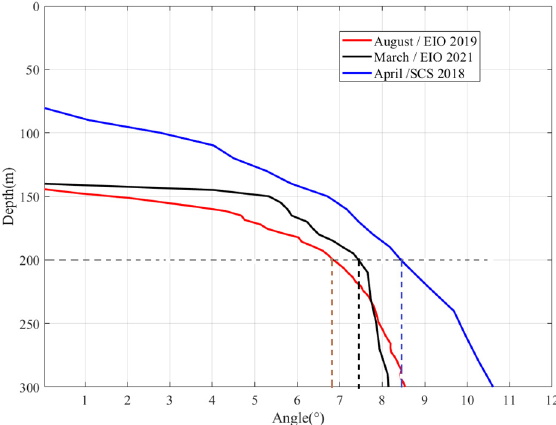
Figure 12. Maximum emission angle of the ray with different source depth for forming a CZ in the three experiments.